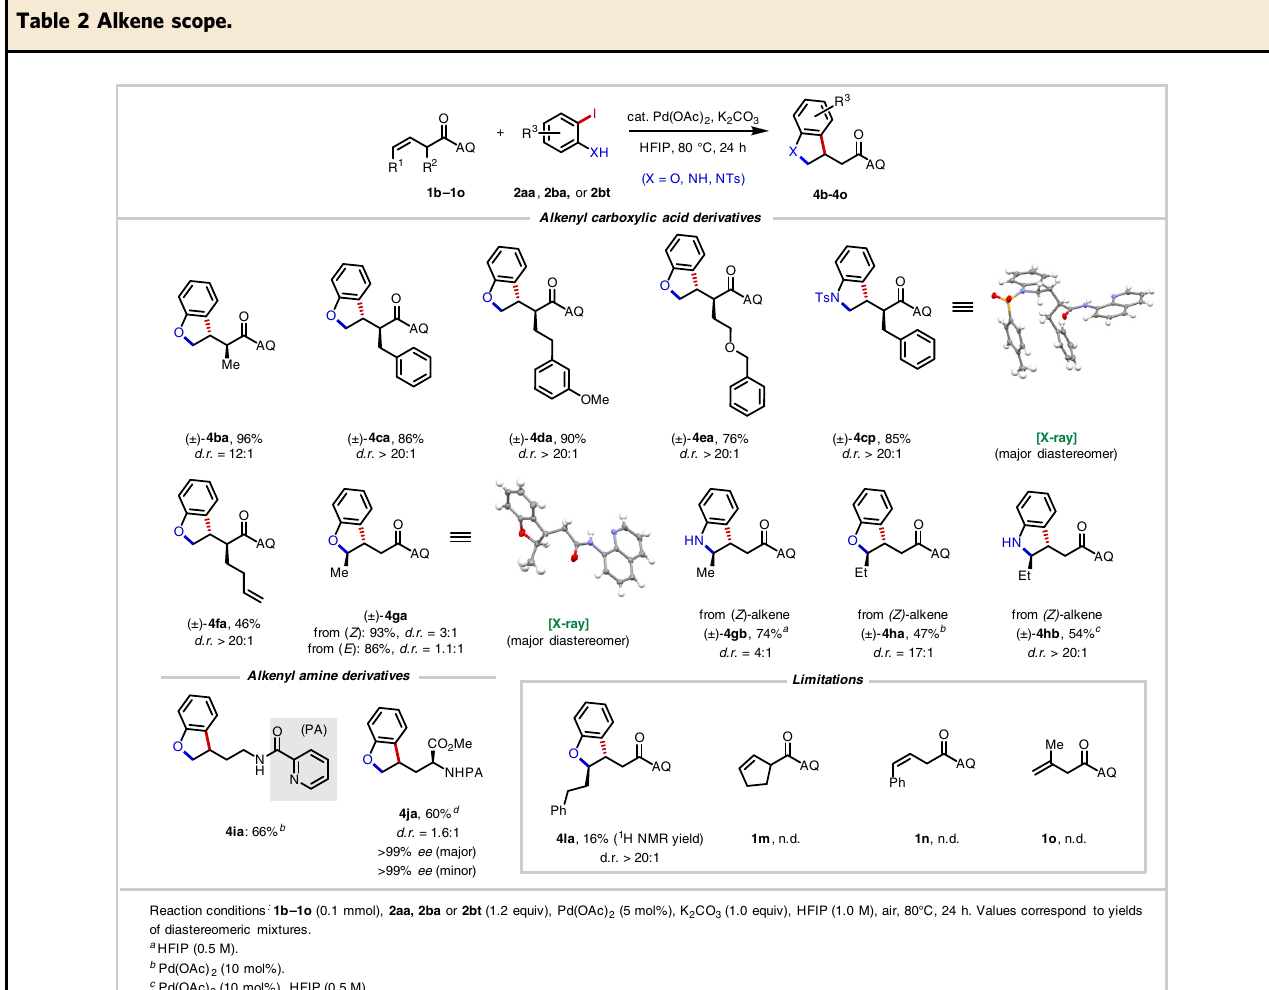
Table 2 Alkene scope.